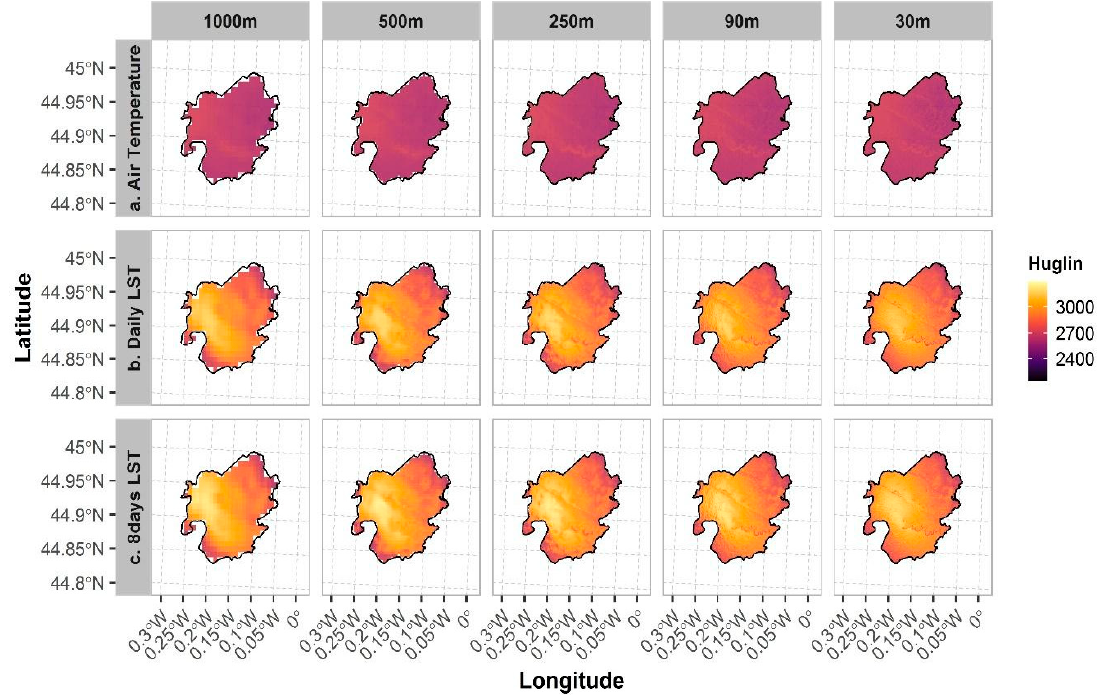
Figure 8. Spatial distribution of the Huglin index averaged from 2012–2018 and gridded at different spatial resolutions using ( a ) predicted air temperature, ( b ) downscaled daily land surface temperature (LST) (M*D11A1) and ( c ) downscaled 8-day LST (M*D11A2).